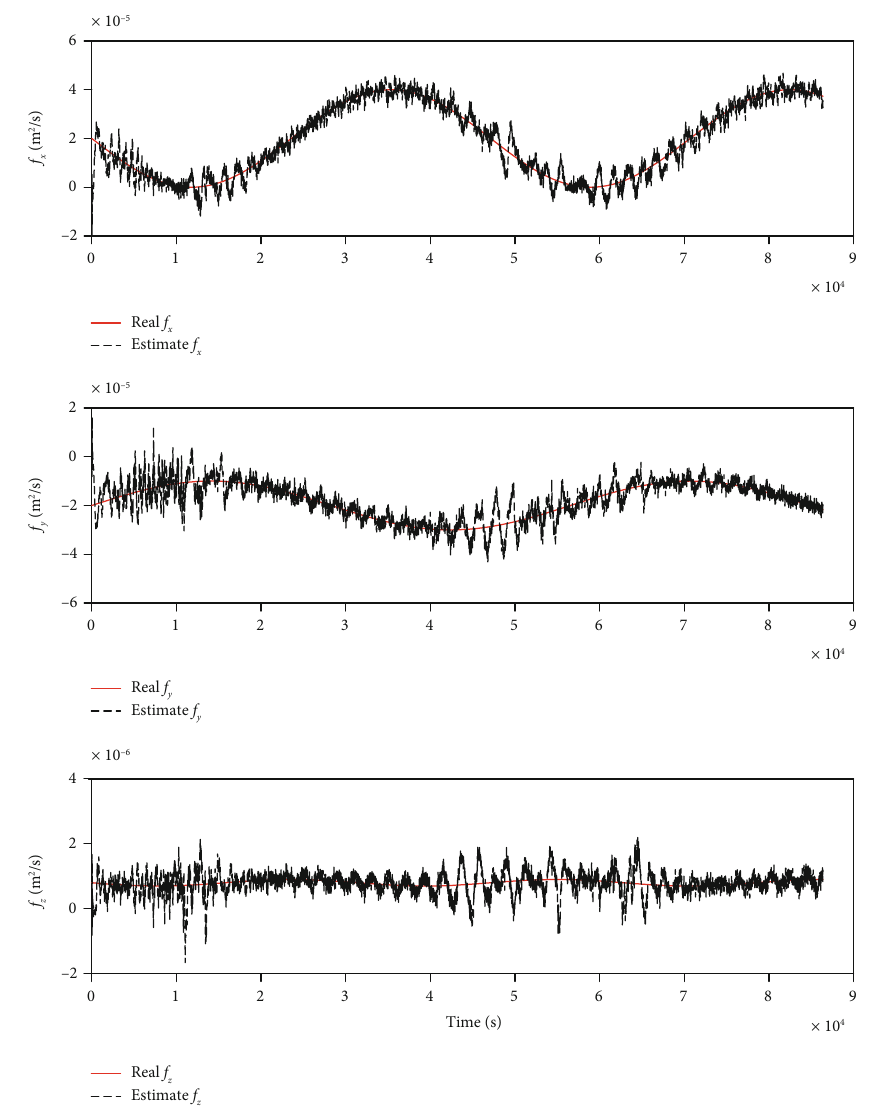
Figure 11: The approximation of the neural network to nonlinear